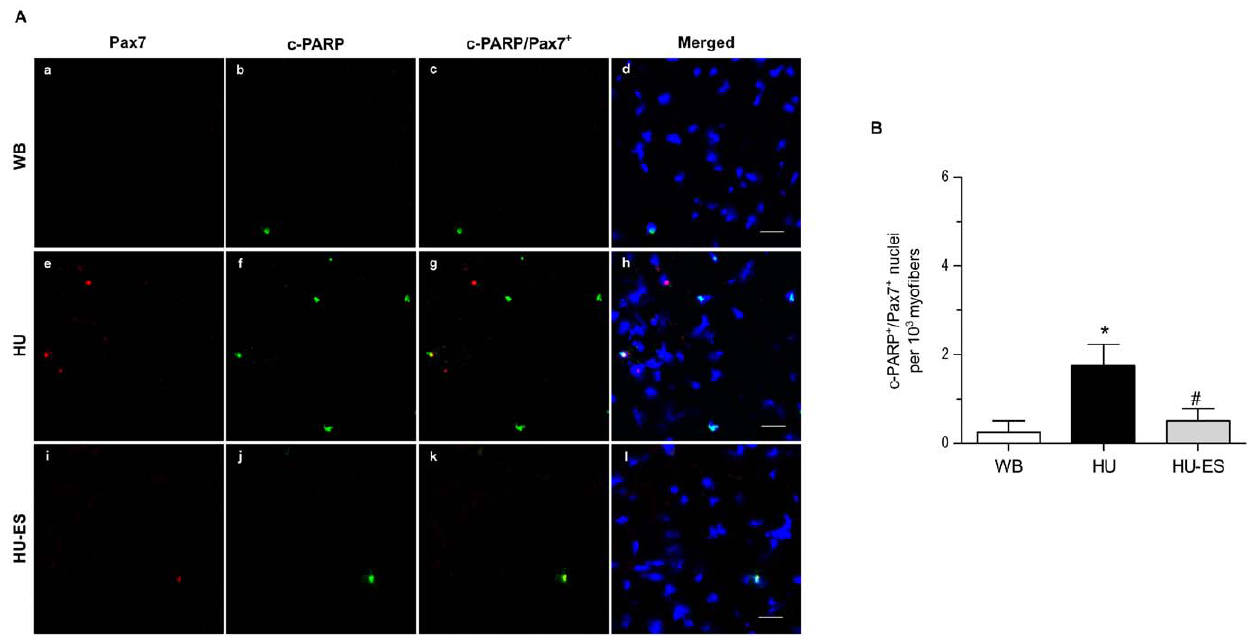
Figure 3. Satellite cell apoptosis. (A) Immunohistochemically stained cross-sections of soleus muscle from weight-bearing (WB), hindlimb- unloaded (HU), and electrically stimulated (HU-ES) groups showing expression of Pax7 (red) and cleaved PARP (c-PARP, green) counterstained with DAPI (blue) for nuclei identification. Yellow staining represents Pax7 and cleaved PARP double-positive nuclei. Scale bar=25 m m. (B) c-PARP + /Pax7 + double-positive nuclei per 10 3 myofibers for different groups. *p , 0.05, significant difference compared to WB group; # p , 0.05, significant difference compared to HU group. Values are means 6 SEM.